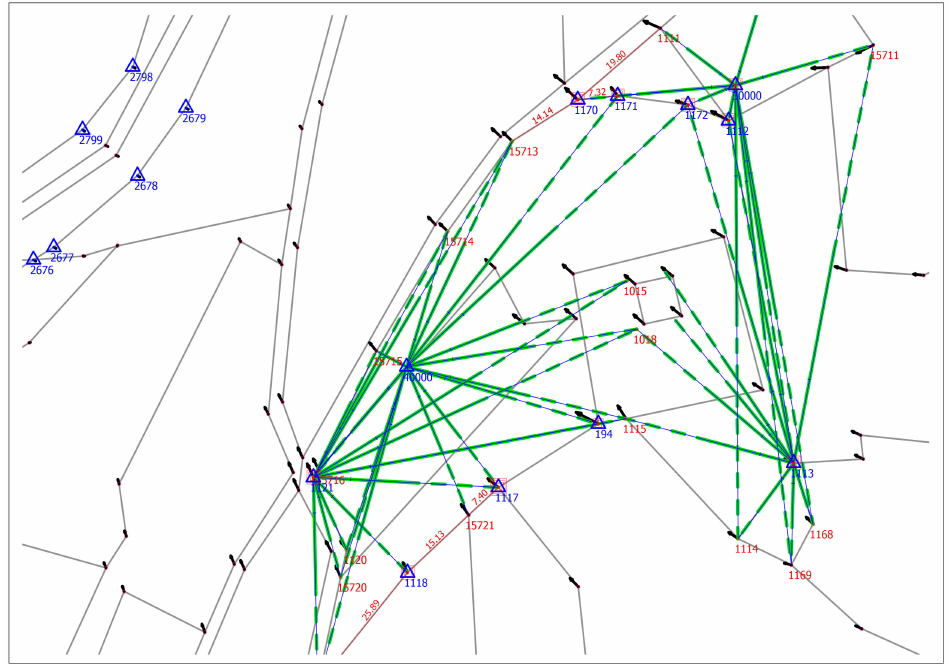
Figure 2. Adjusted fieldbook geometric data of cadastral case and proximity fitted neighborhood of cadastral case—subject digital cadastral map (DCM) (gray) and shift vectors